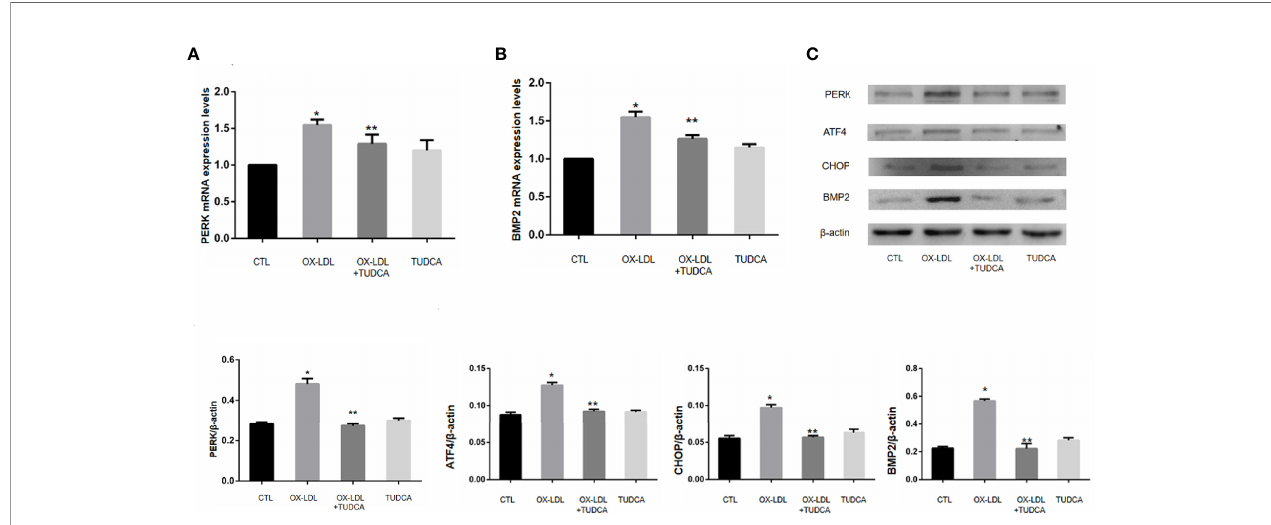
FIGURE 4 | TUDCA can improve the osteogenic phenotype transformation of VICs. (A) PERK mRNA expression levels. (B) .BMP2 mRNA expression levels. (C) Immunoblot analysis of the pore-forming mediator of Er stress.* represents P value less than 0.05, indicating signi fi cant difference; ** means p value less than 0.01, indicating extremely signi fi cant